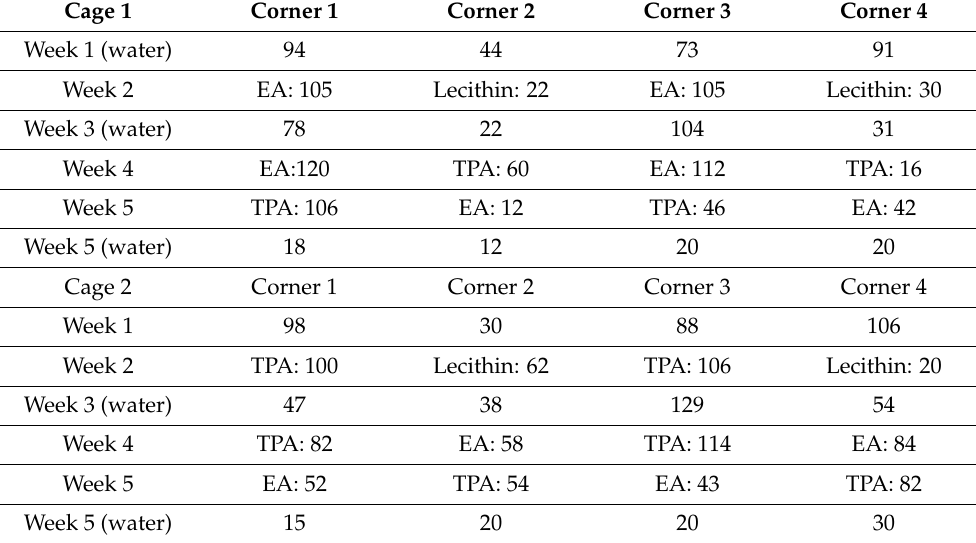
Table 1. Amount of solution consumption in each week for different corners (mL).